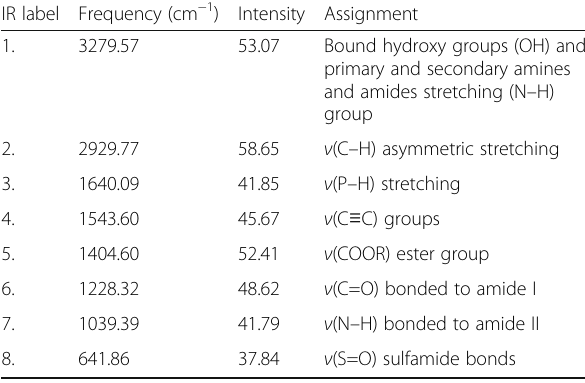
Table 2 Functional groups of Lactococcus lactic subsp. lactis without cholesterol and the corresponding infrared absorption